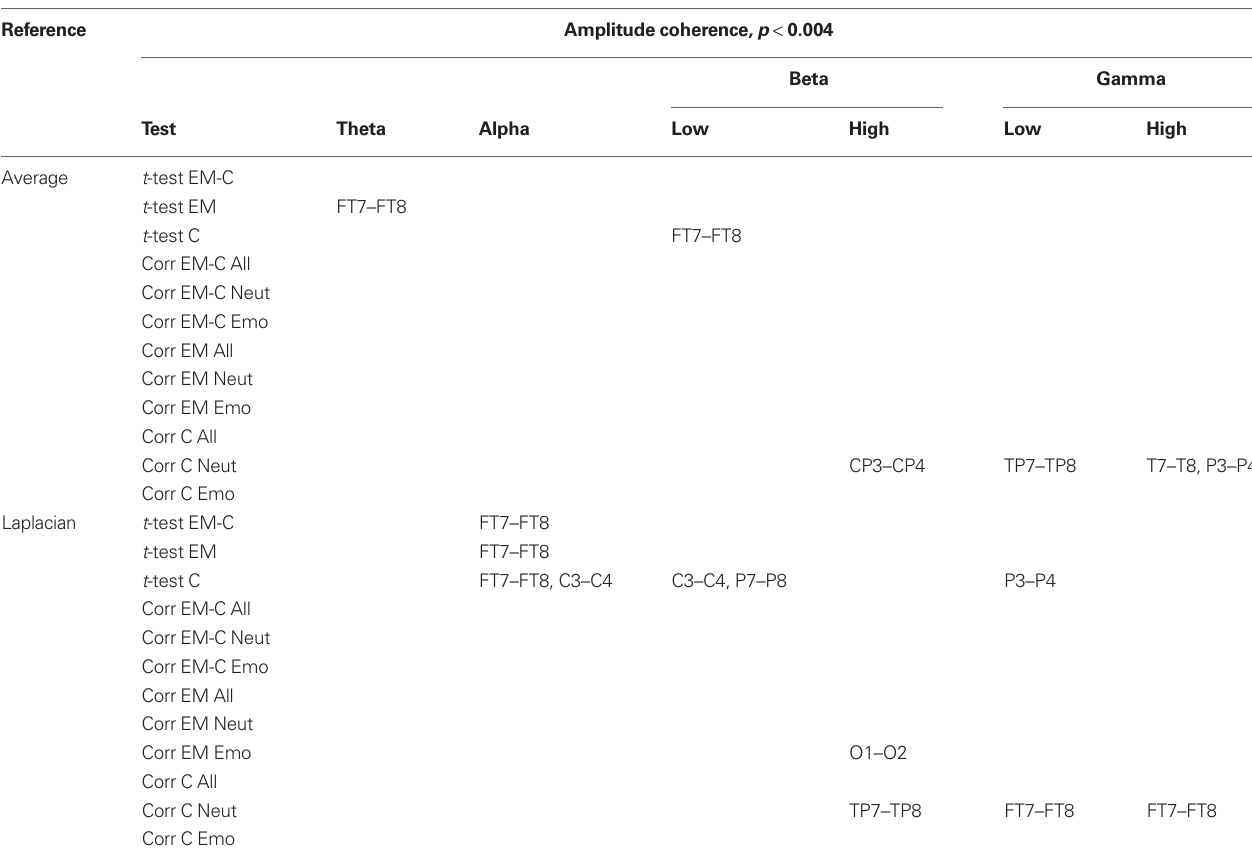
Table 3 | Summary of significant changes in amplitude coherence for the average and the Laplacian reference scheme (significance threshold adjusted for number of electrode pairs).